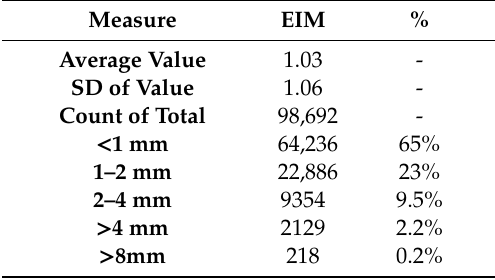
Table 1. Summary of results of embankment instability metric from population of 10-yard segments.